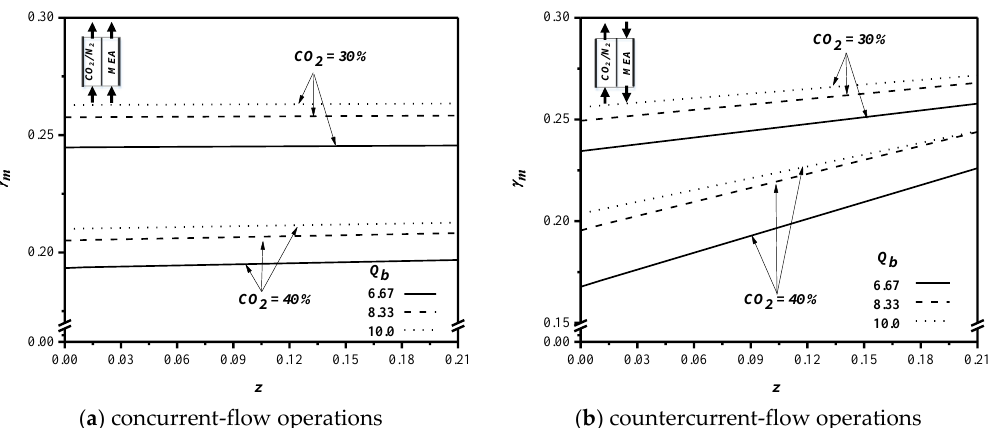
Figure 10. Effects of the MEA flow rate and feed CO 2 concentration on m γ . ( a ) concurrent-flow Figure 10. E ff ects of the MEA flow rate and feed CO 2 concentration on γ m . ( a ) concurrent-flow operations; ( b ) countercurrent-flow operations. operations; ( b ) countercurrent-flow operations.